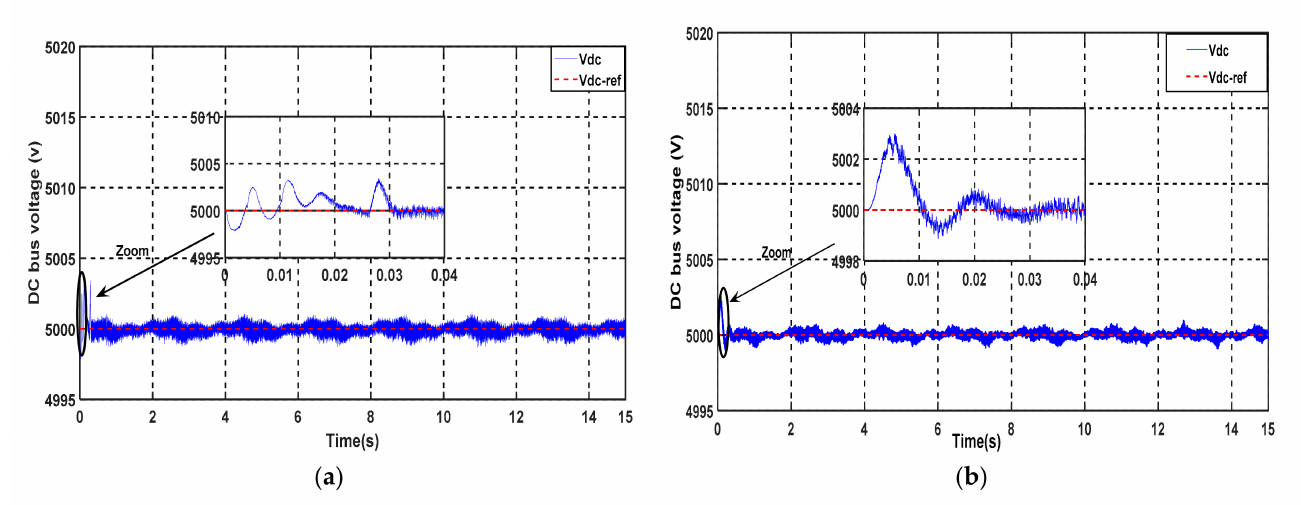
Figure 9. DC link voltage: ( a ) using CSMC and ( b ) using